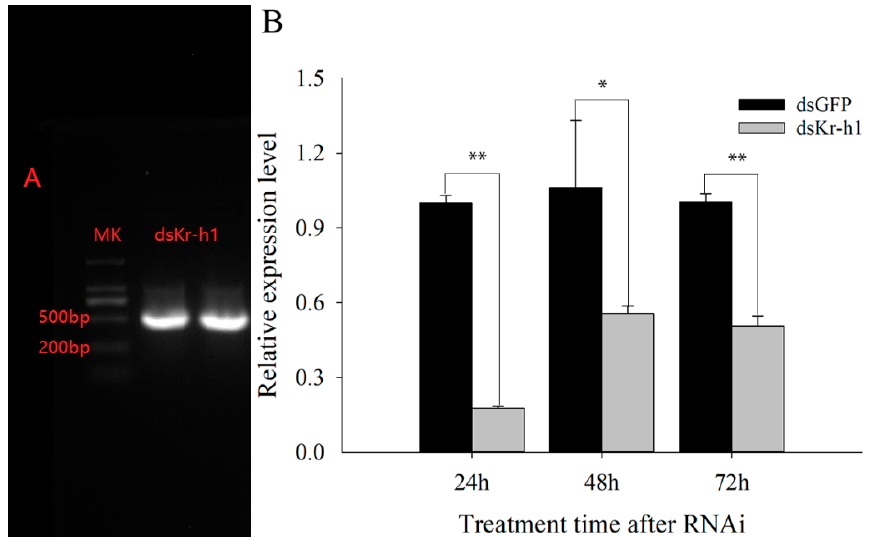
Figure 5. The relative expression levels of genes after Kr-h1 was knocked down by RNAi. ( A ) Gel electrophoresis of ds Kr-h1 . ( B ) Relative expression level of Kr-h1 . * and ** show significance at p < 0.05 and 0.01 levels with Student’s t -test, respectively.